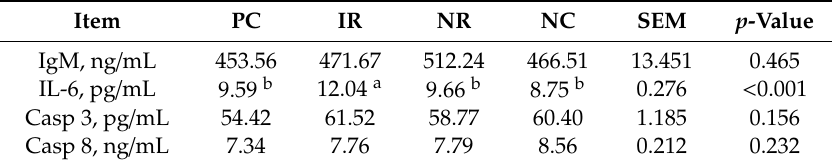
Table 5. Indicators of immune status and apoptosis in